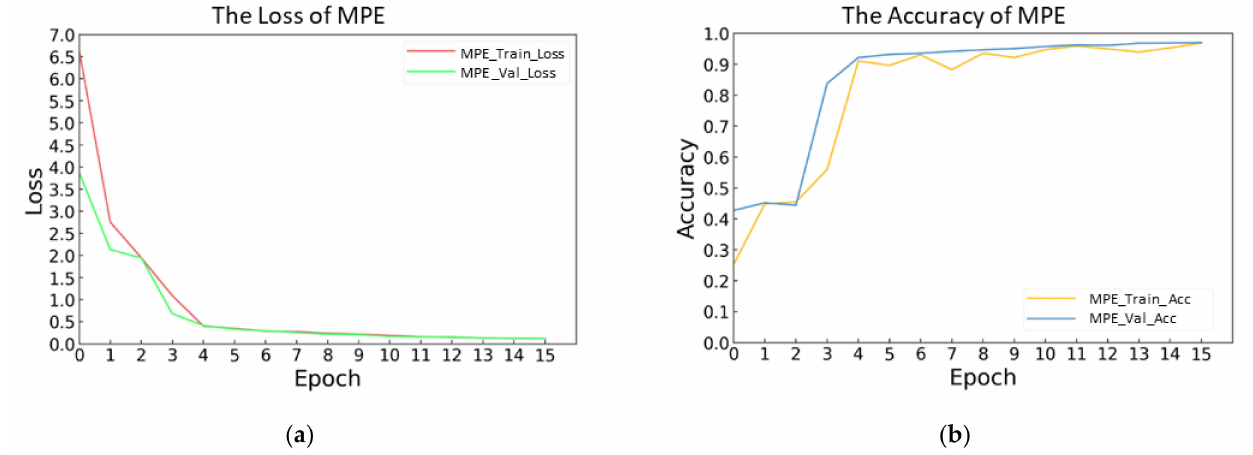
Figure 5. Masked predictive encoder (MPE): ( a ) The loss of MPE. ( b ) The accuracy of MPE.